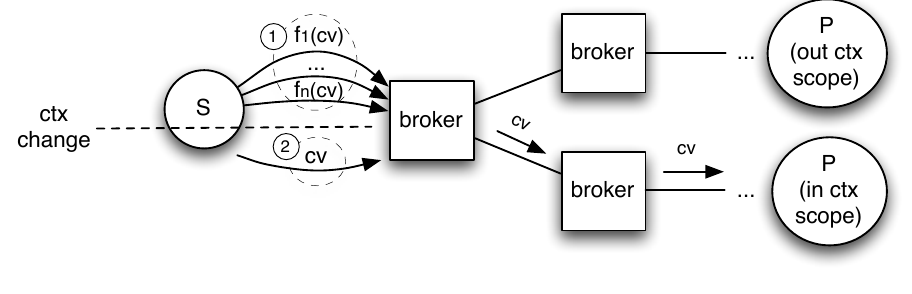
Figure 2. Exchange of messages with our proposed explicit context management.